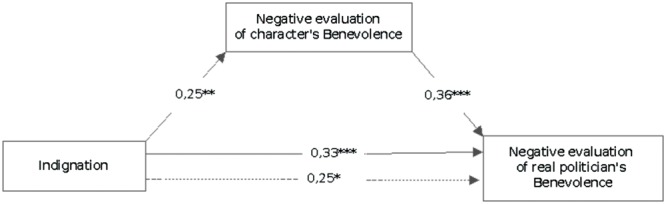
Mediational regression analyses of indignation and negative evaluation of character’s benevolence on negative evaluation of real politician’s benevolence.
∗p < 0.05; ∗∗p < 0.01; ∗∗∗p < 0.001. Solid lines between variables denote direct paths between two variables. Dotted lines denote paths when negative evaluation is included as mediator. Values denote standardized Beta weights.